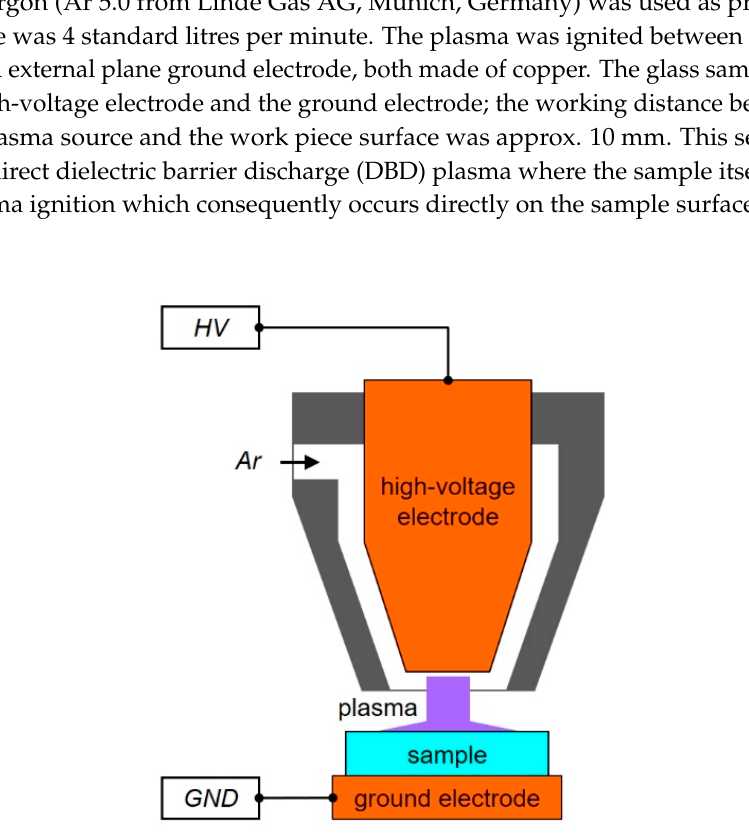
Figure 3. Experimental setup for plasma post-processing of polished glass samples applying a direct dielectric barrier discharge (DBD)